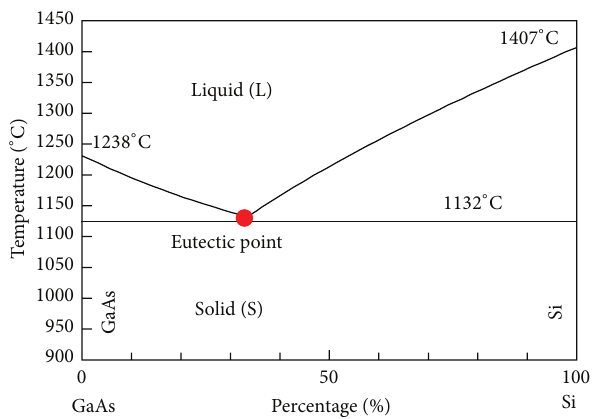
Figure 5: Ga-As-Si phase diagram [16] is chosen as a typical phase diagram for III–V-Si